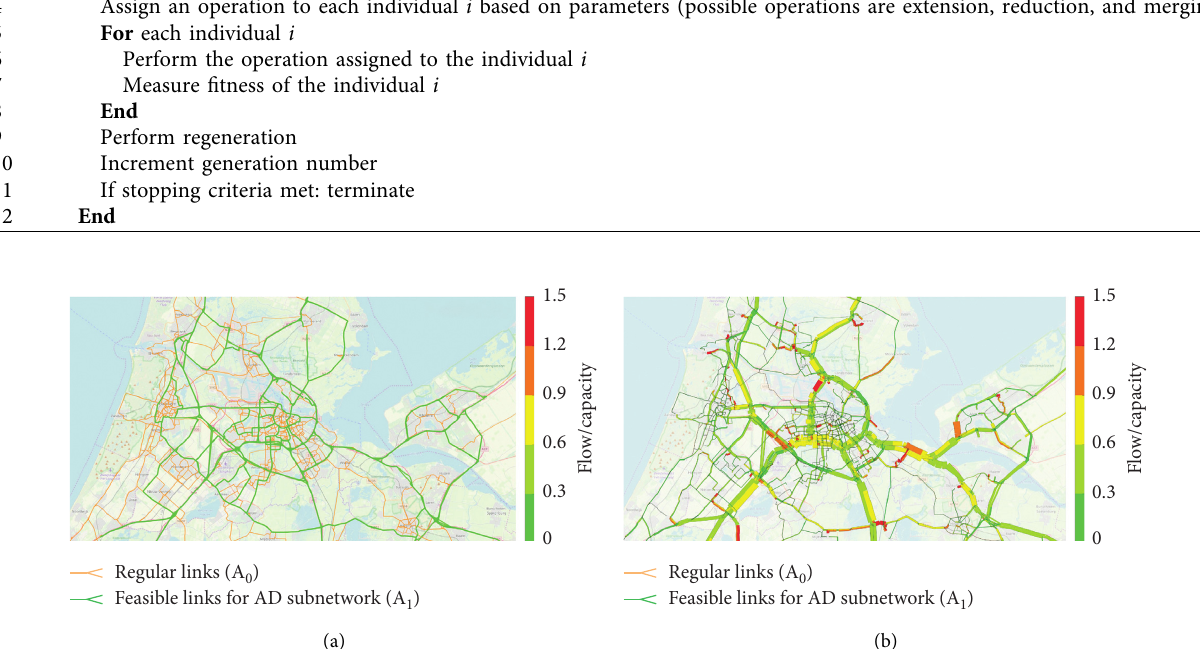
Figure 3: Feasible links for AD subnetwork and base case traffic patterns in Amsterdam network. (a) Feasible links for AD subnetwork. (b) Base case traffic